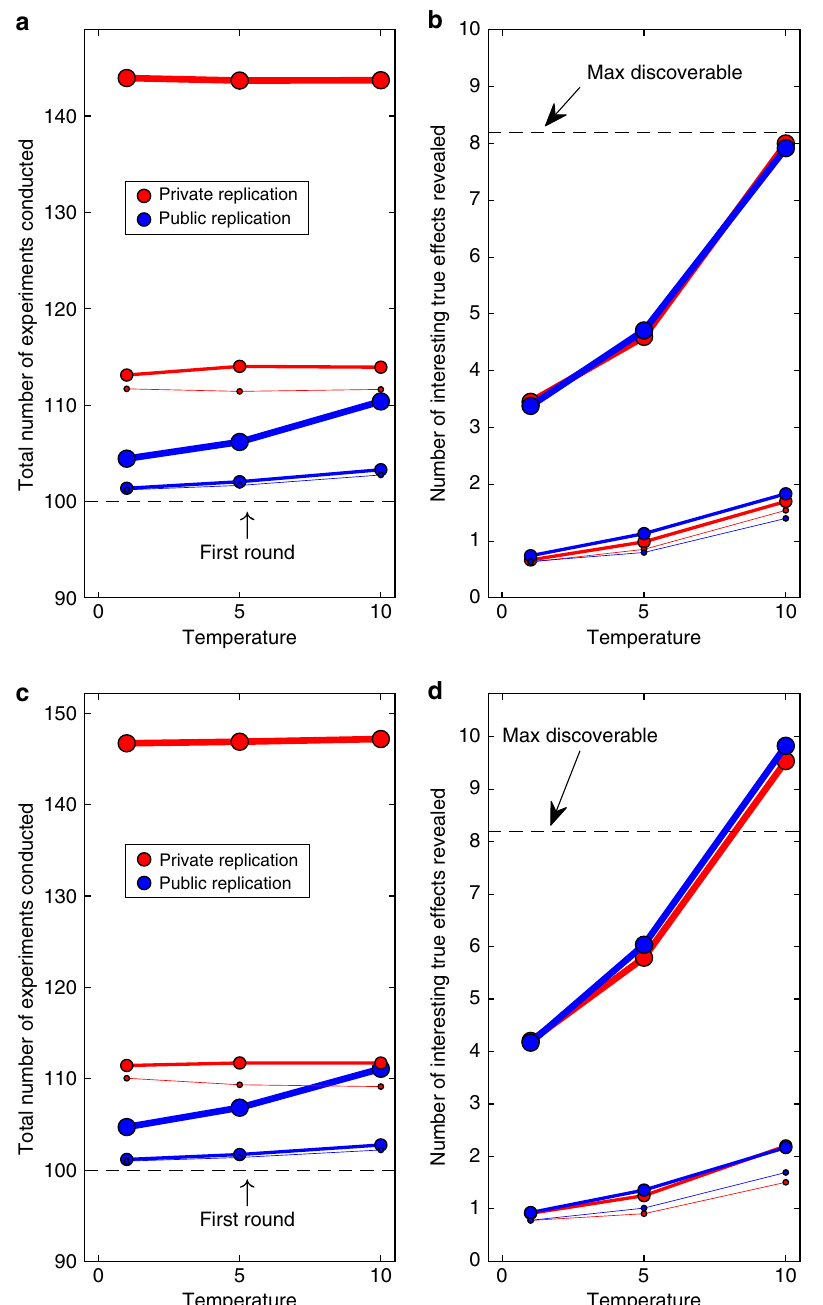
Fig. 7 Scienti fi c achievements and costs for theory-testing research. The frequentist analysis is shown in a and b , and Bayesian tests for the presence of effects in c and d . a and c show the cost (total number of experiments conducted) to generate the knowledge (true effects discovered) shown in b and d . In all panels, the thickness of lines and size of plotting symbols indicates the value of ρ , which captures overlap between the theory and reality. In increasing order of thickness, ρ was 0.1, 0.5, and 1.0. Temperature refers to the temperature of the logistic decision function (Methods section). All successful replications shown in b and d are true (i.e., the null hypothesis was actually false). Signi fi cant replications that did not capture true effects are omitted to avoid